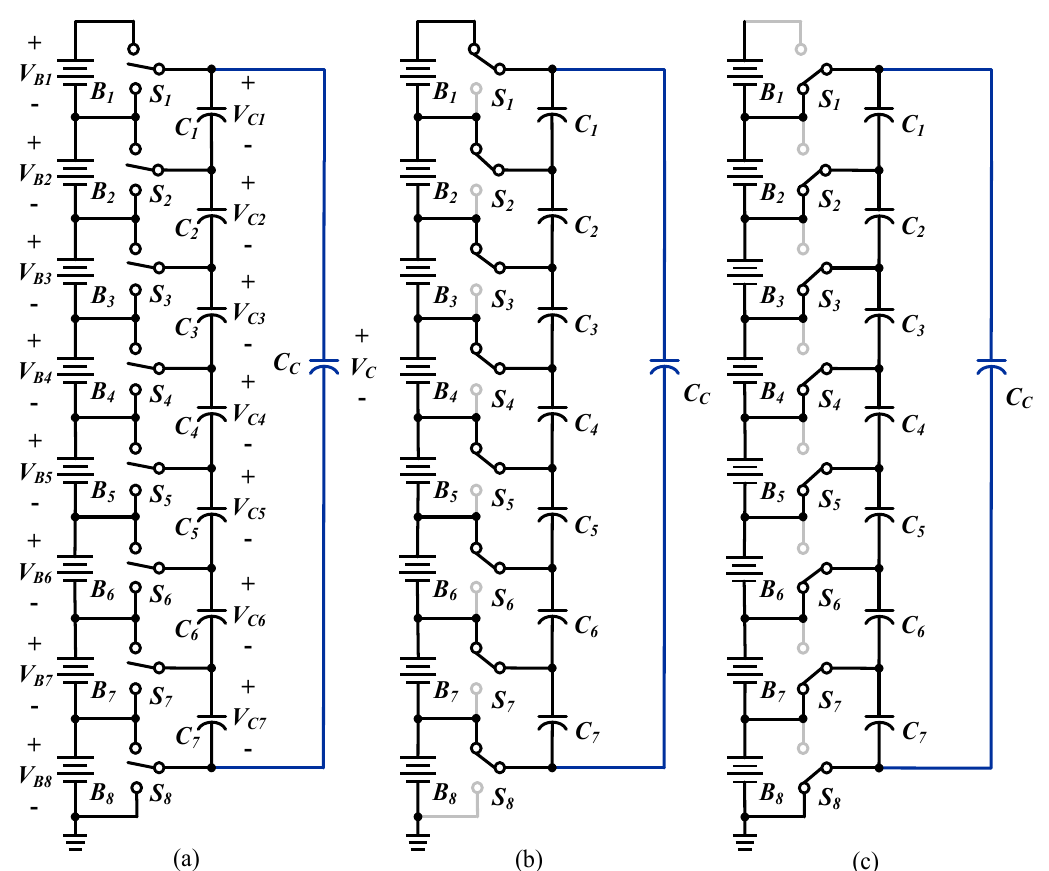
Figure 5. Chain structure of SC-based BE type II*: ( a ) circuit architecture; ( b ) first state; ( c ) second state. * Eight batteries are shown as examples.